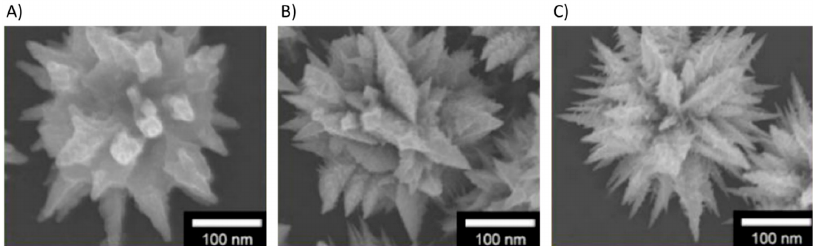
Figure 7. SEM images of electrodeposited palladium structure with various sulfuric acid concentrations ( A ) 1M, ( B ) 0.1M, ( C ) 0.01M. Reproduced with permission from ref. [105].